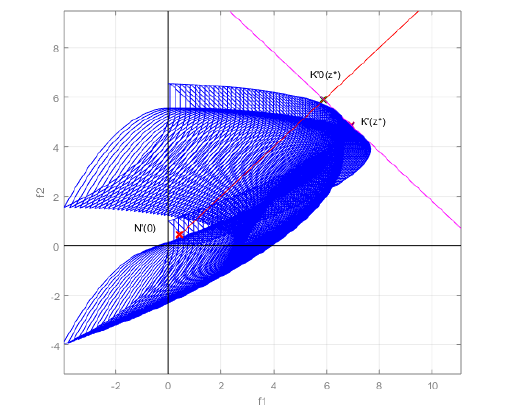
( z ∗ ) , possible sharing of the collective gain realized in µ 0